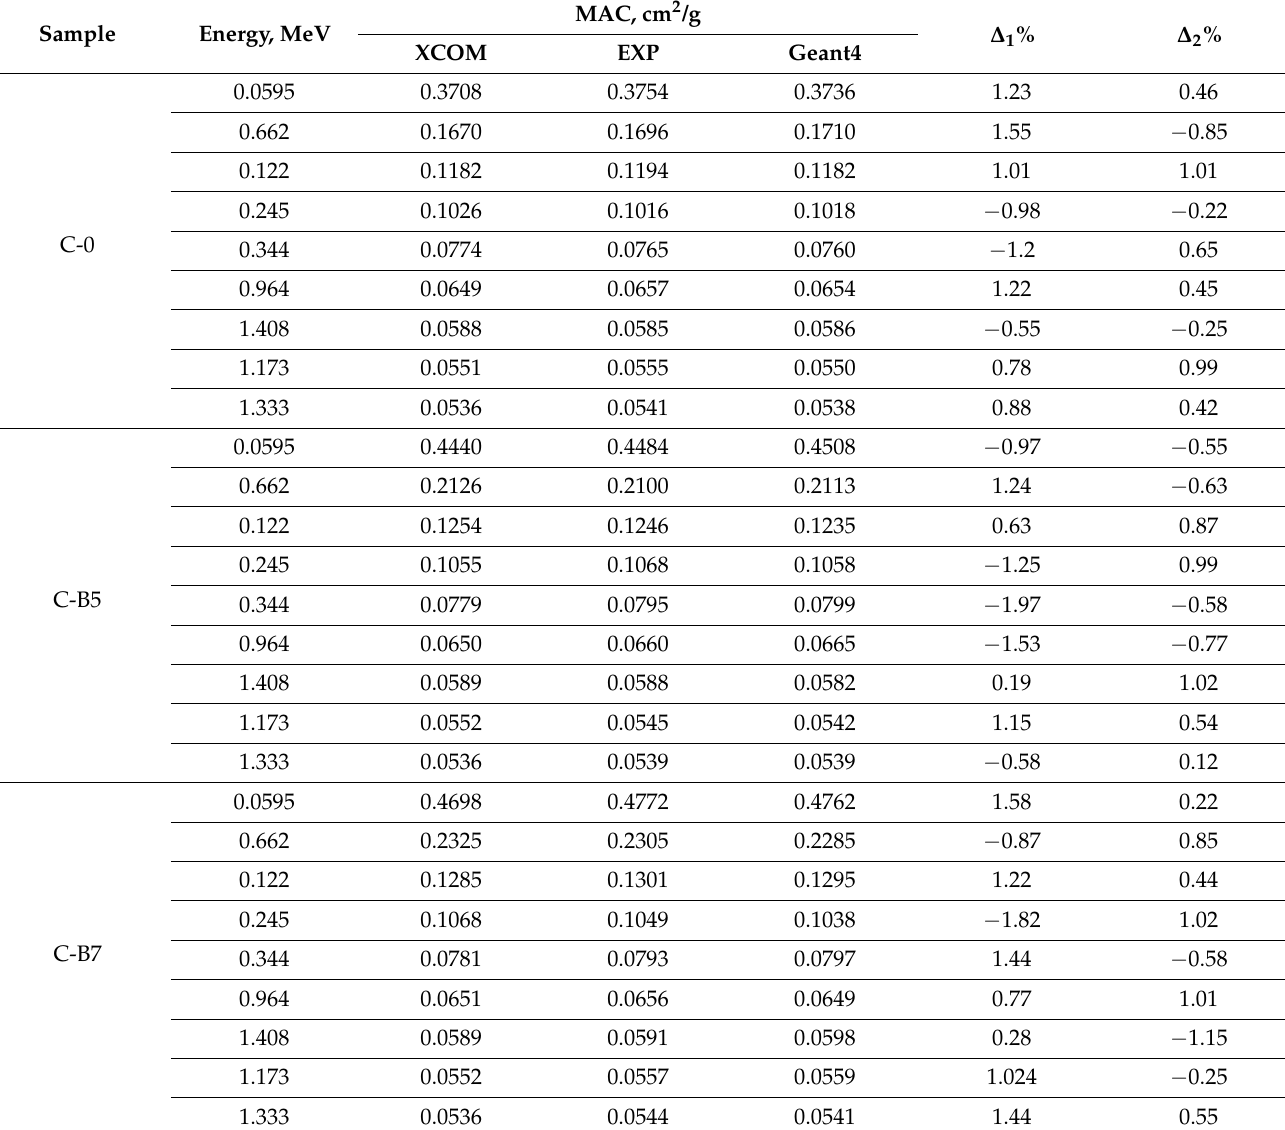
Table 4. The MAC of bulk samples using experimental and theoretical methods and the relative deviation between the experimental and XCOM ( ∆ 1 % ) as well as the relative deviation between the experimental and Geant4 simulation ( ∆ 2 % ).